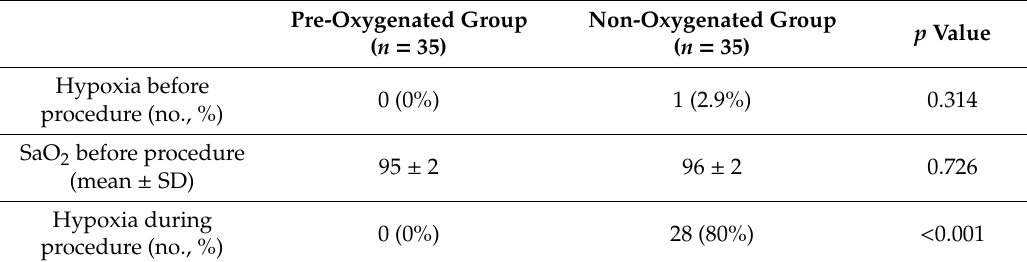
Table 2. Incidence of hypoxia in both groups.